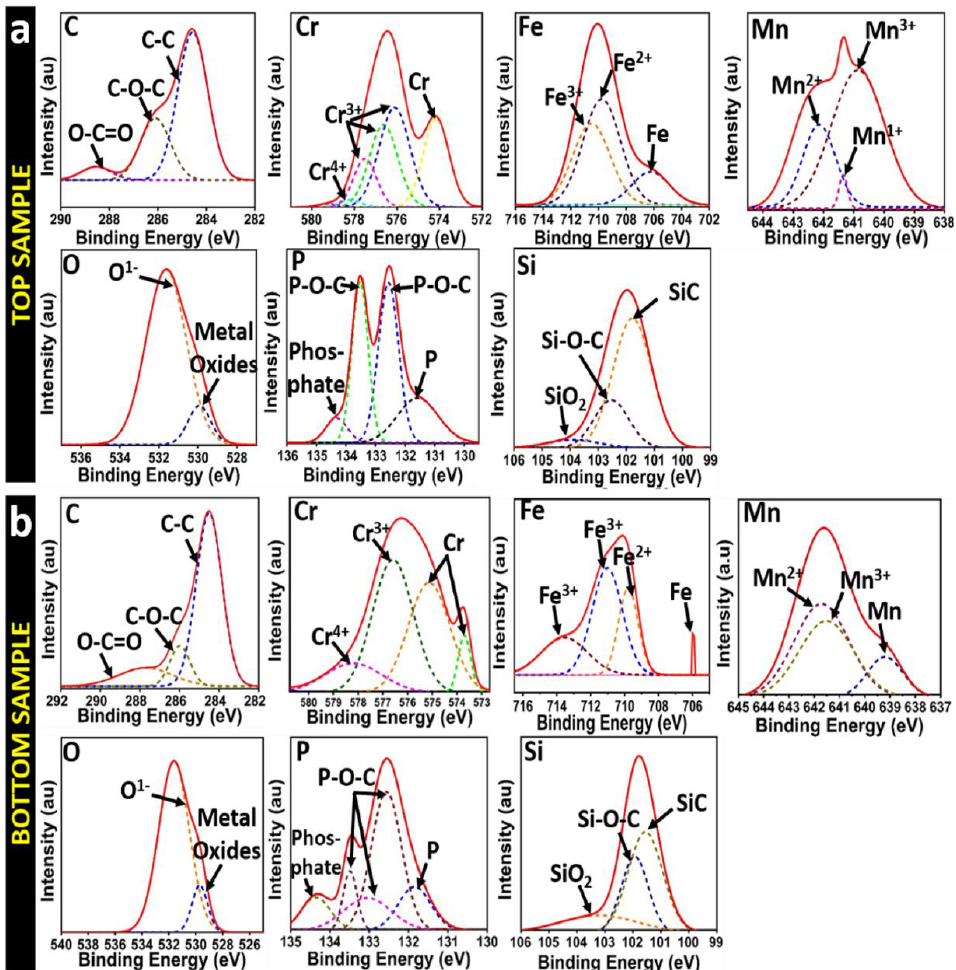
Figure 13. The XPS characterization of different elements in the ( a ) top and ( b ) bottom specimens manufactured using the CMT − based WAAM process.